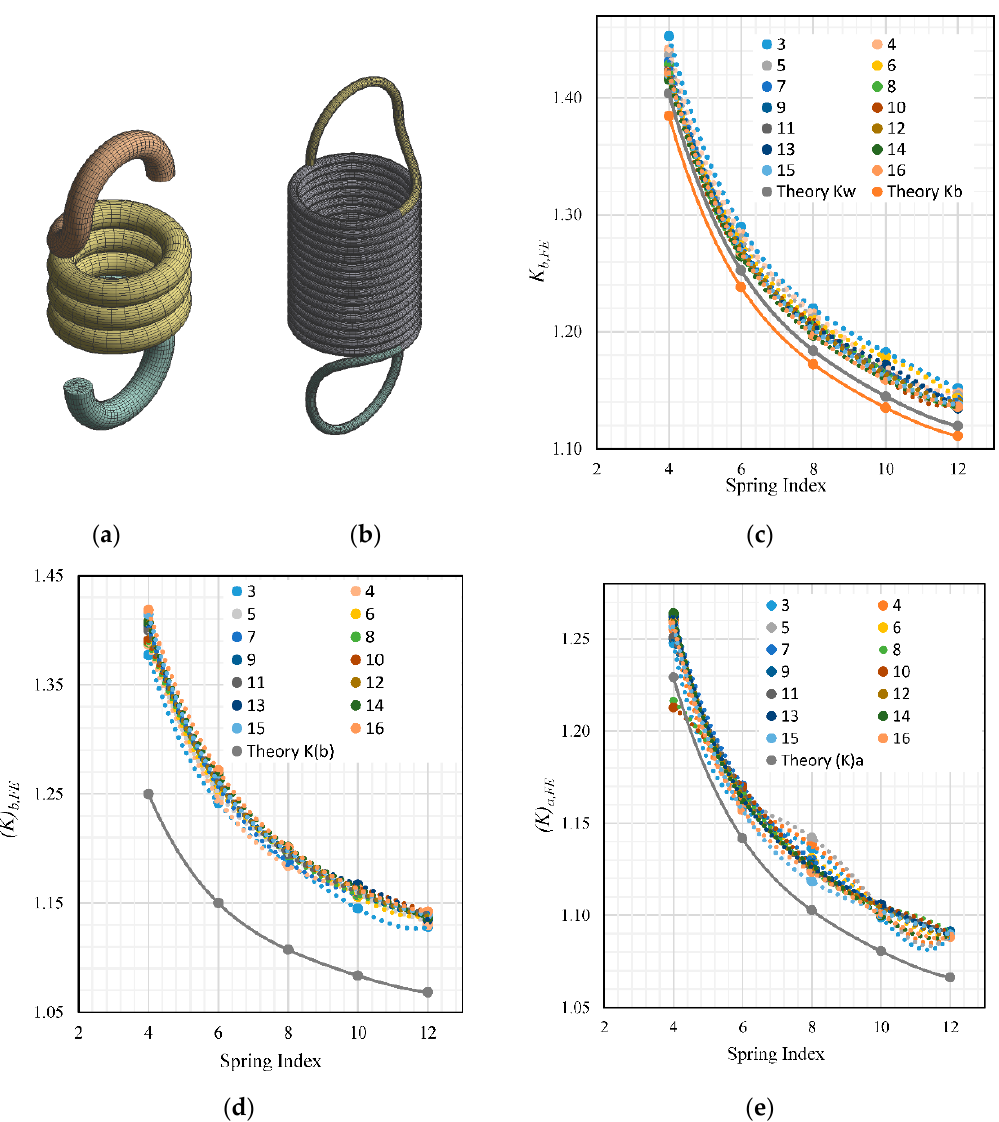
Figure 10. Change of parameter from ( a ) N = 3, C = 4 to ( b ) N = 16, C = 12; e ff ects of spring index and number of coils against ( c ) K b , FE , ( d ) ( K ) b , ( e ) ( K ) a , FE , FE